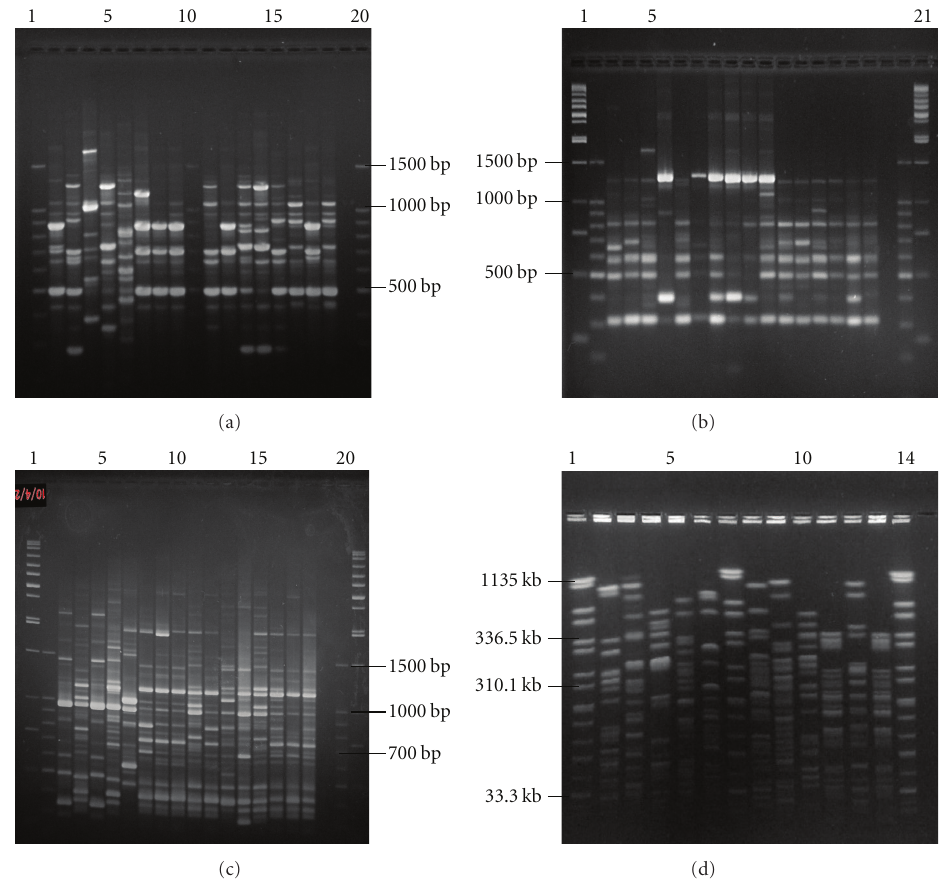
Figure 1: (a) Representative ERIC-PCR profiles for E. coli isolates. Lanes 1, 10, 20: 100bp DNA ladder, lanes 2–4: EC1-EC3; lanes 5–9: EC17, EC19, EC18, EC30, EC34, lanes 11–18: EC32, EC14, EC41, EC39, EC42, EC22, EC45, EC46; lane 19: negative control. (b) Representative RAPD profiles for E. coli isolates. Lanes 1, 21: 1kb DNA ladder; lane 2, 20: 100 bp DNA ladder; lanes 3–18: EC5, EC8, EC13, EC15,